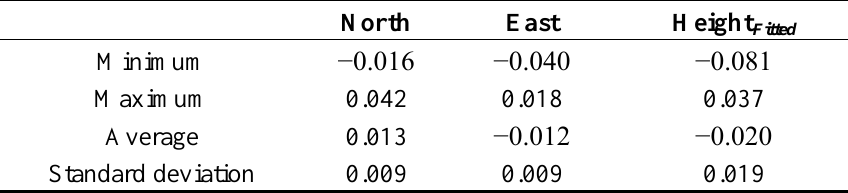
Table 3. Statistical table for positioning errors at U0999 in network RTK positioning (unit: